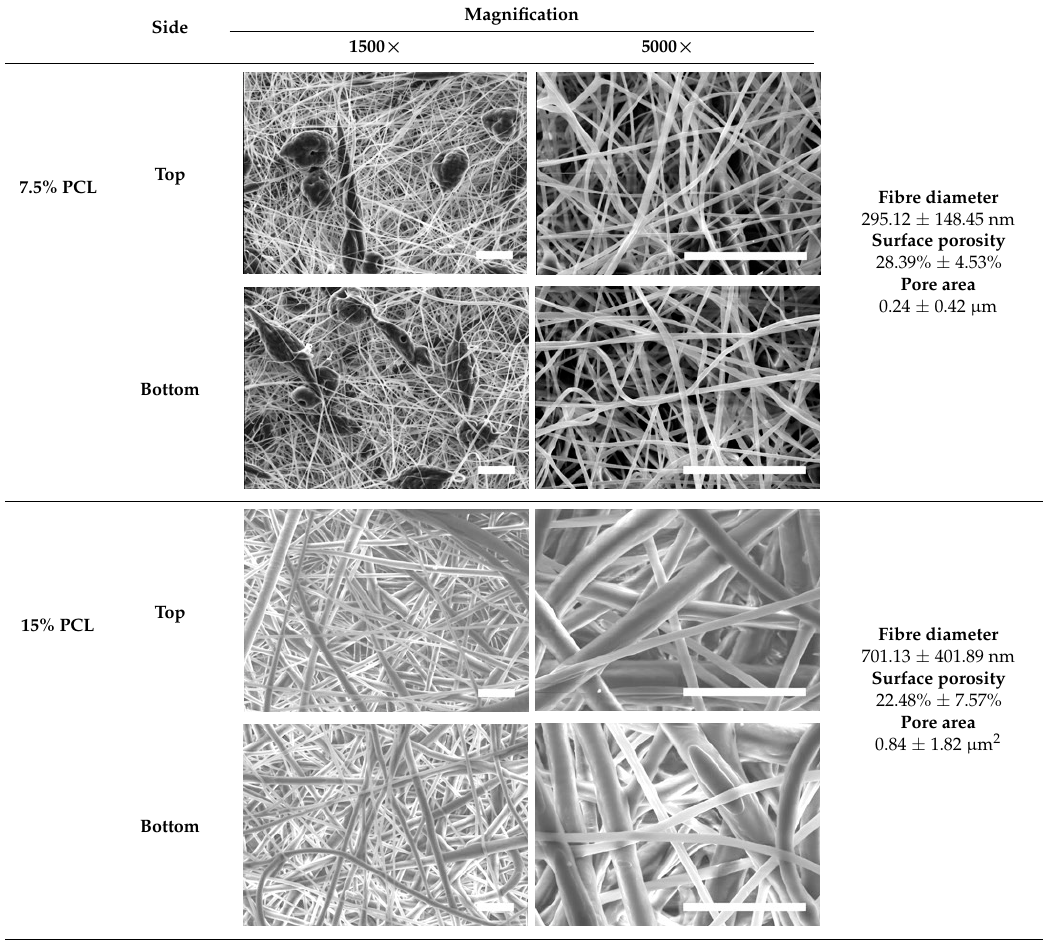
Table 1. Microscopic characterization of 7.5% and 15% electrospun poly ( ε -caprolactone) (PCL) scaffolds (7 kV, 6 mL/h). Top and bottom sides were visualized through scanning electron microscopy micrographs at different magnifications. Both sides were used to calculate fiber diameter, surface porosity and pore area. (Scale bars: 10 µ m).